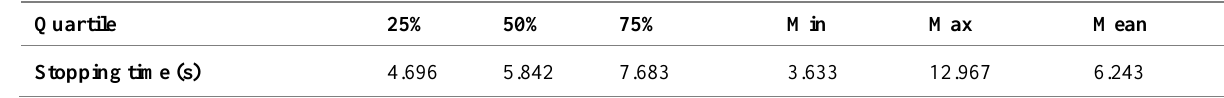
Table 4 . Quartile statistics of stopping time.